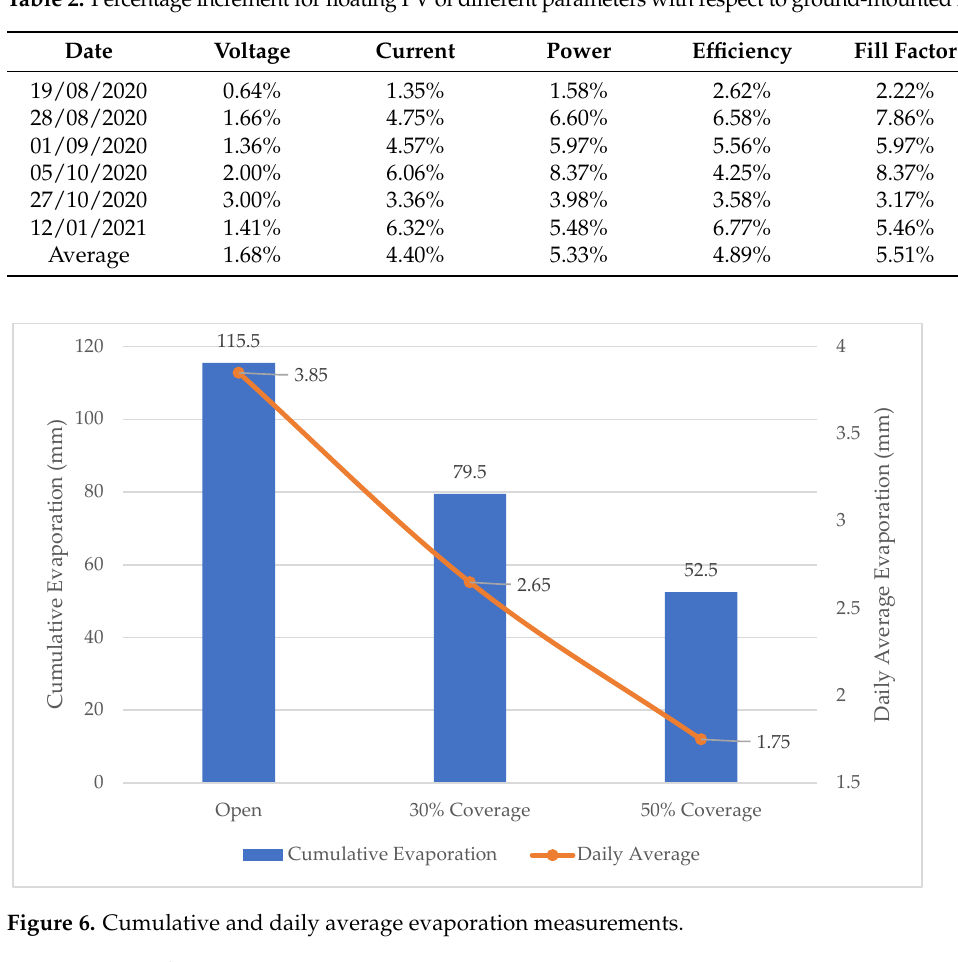
Table 2. Percentage increment for floating PV of different parameters with respect to ground-mounted PV.